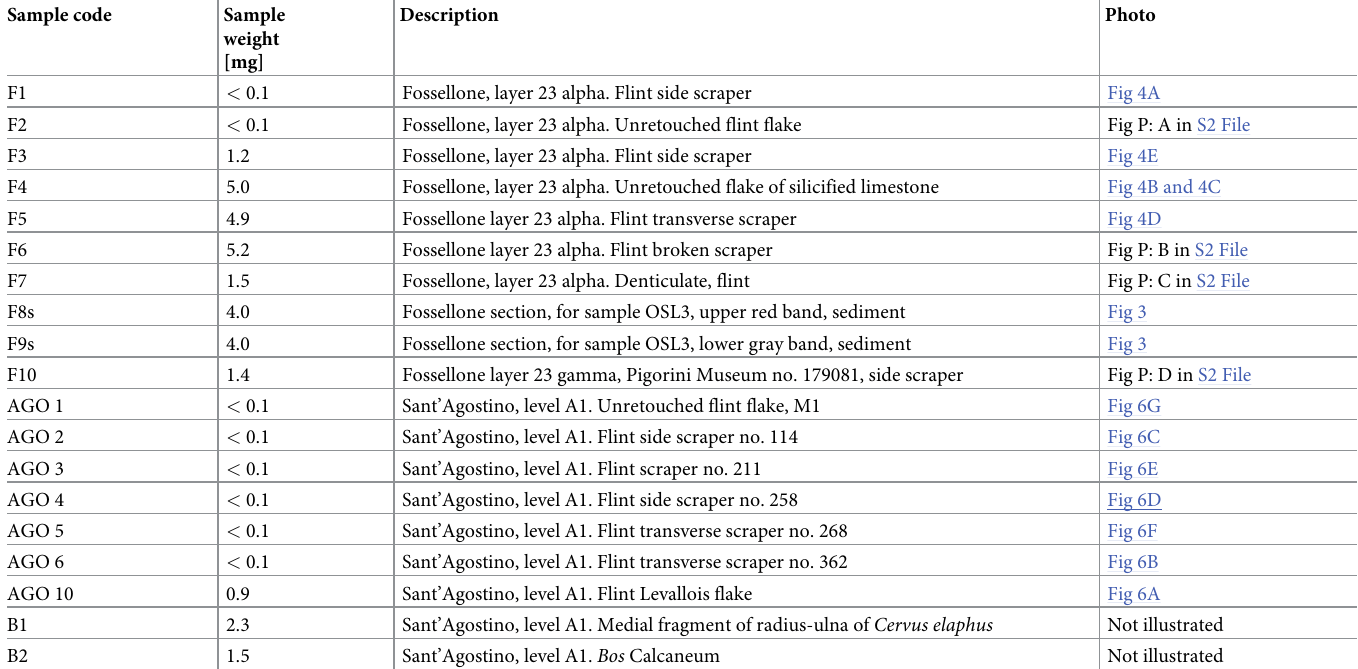
Table 7. Description of the artifacts and weight of the analyzed